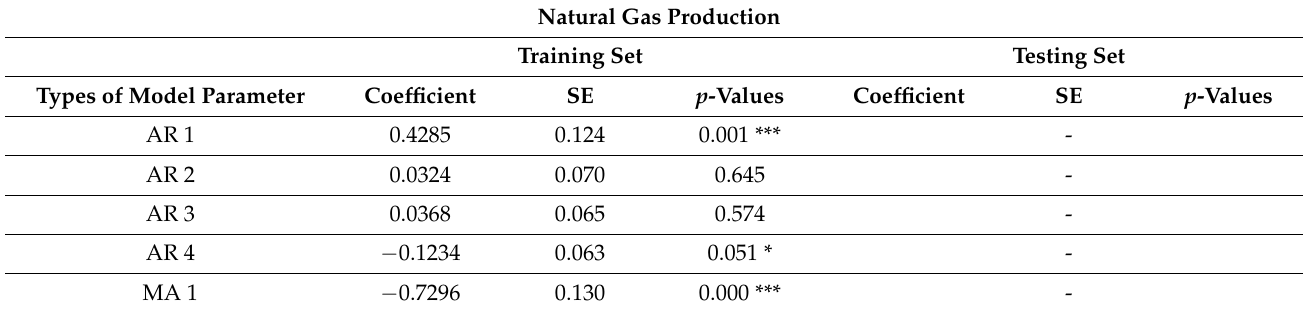
Table 4. Final parameter estimates for the SARIMA model in natural gas production and